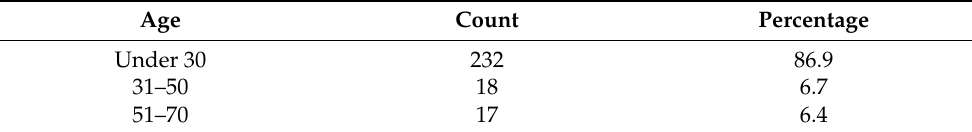
Table 2. Age: control